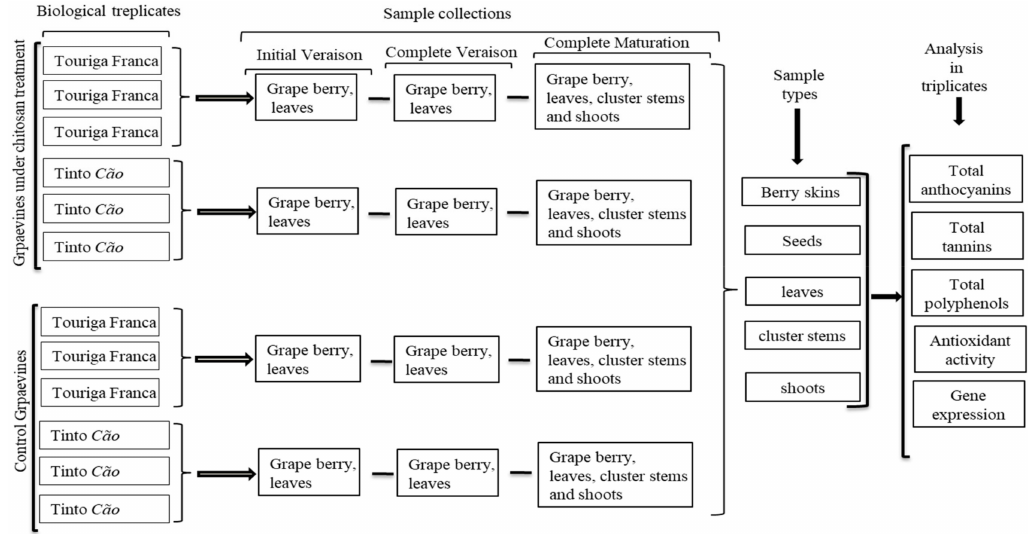
Figure 1. Diagrammatic representation of the complete experimental setup, including sample collection and sample